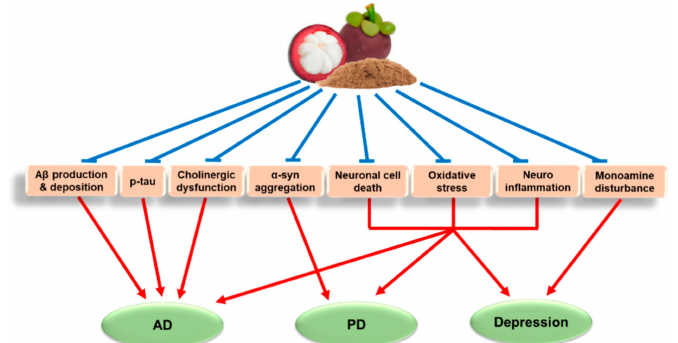
Figure 2. Mechanisms of actions of mangosteen pericarp (MP)-derived agents to combat Alzheimer’s disease (AD), Parkinson’s disease (PD), and depression. MP-derived agents, including dietary supplements, extracts, and bioactive xanthones isolated from MP, inhibit A β production and deposition, tau hyperphosphorylation (p-tau) and cholinergic dysfunction in various in vitro and in vivo AD models. These agents abate α -synuclein ( α -syn) aggregation in PD models, and diminish monoamine disturbances in depression models. Moreover, the agents mitigate neuronal cell death, oxidative stress, and neuroinflammation, which further contribute to their pharmacological e ff ects to combat progression of these